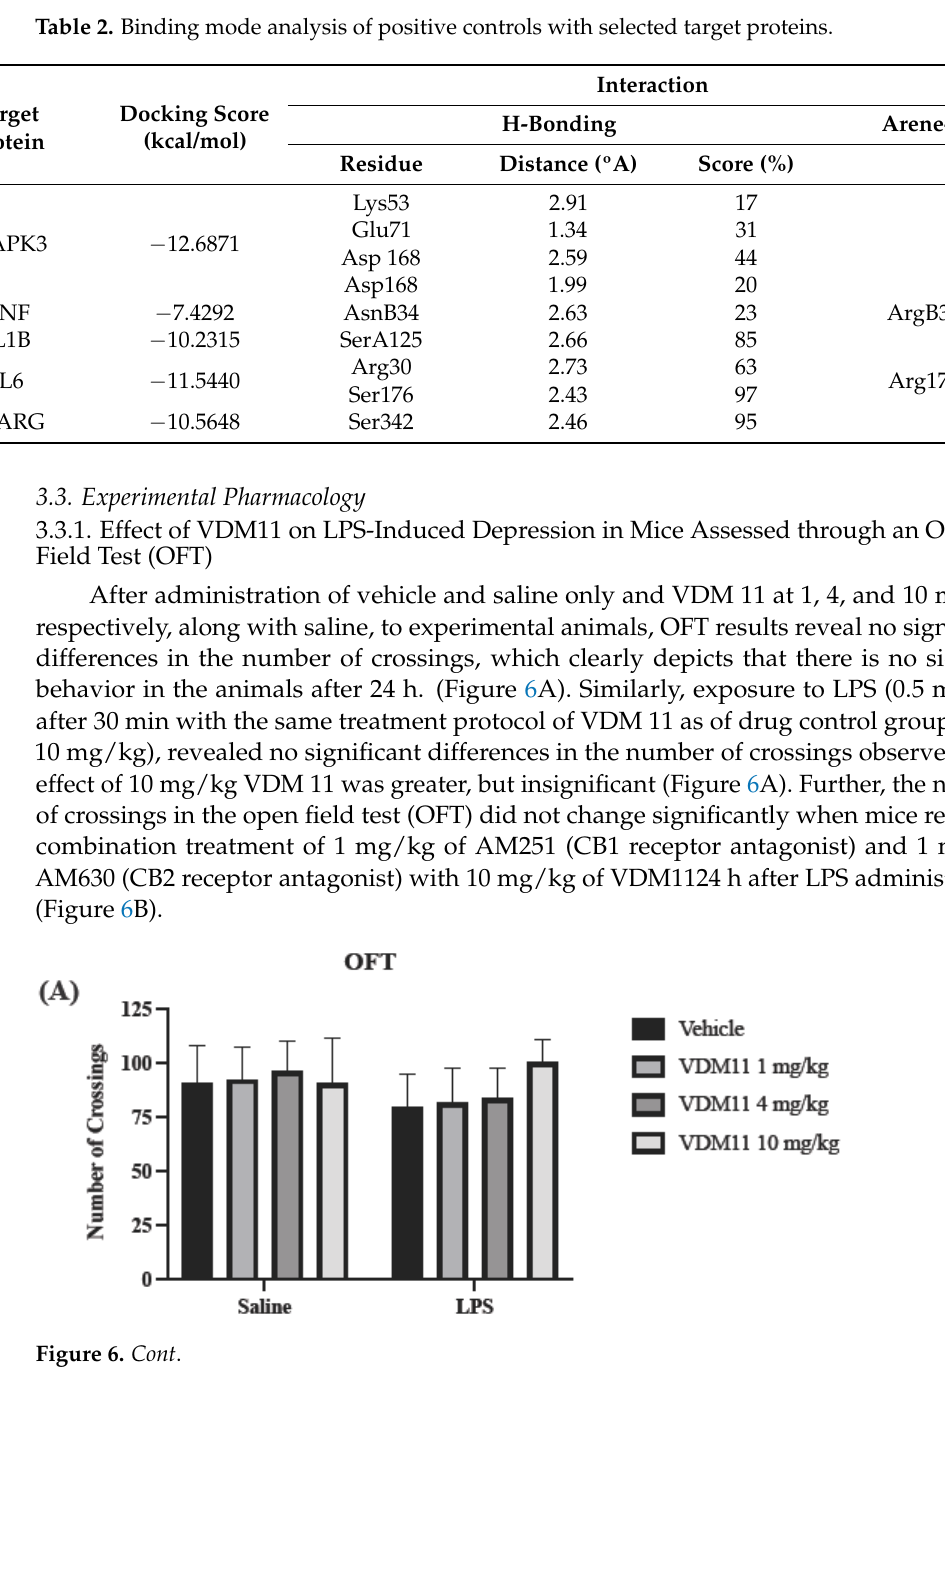
Figure 6. ( A ) Mice given various doses of VDM11, an anandamide reuptake inhibitor, 24 h after LPS injection did not significantly modify the number of crossings in the open field test (OFT). ( B ) Mice treated with a combination of 1 mg/kg each of the CB1 receptor antagonist AM251 and the CB2 receptor antagonist AM630, along with 10 mg/kg each of the anandamide reuptake inhibitor VDM11 24 h after LPS administration, did not experience a significant change in the number of crossings in the open field test (OFT) . 3.3.2. Effect of VDM11on LPS-Induced Depression in Mice Assessed through Elevated Plus Maze Test The elevated plus maze test was performed after 25 h of LPS administration to ex- perimental animals. The results of the test revealed that there were no significant differ- ences in open arm exploration times in animals when treated with VDM 11 only at differ- ent doses. Meanwhile, administration of LPS to experimental animals significantly re- duced the open arm exploration times % in animals. The open arm exploration time’s percentage was found to be increased in animals which were pretreated with VDM11 at different dose levels. The most significant results were observed at 10 mg/kg of VDM11 pretreatment (Figure 7A). Combination treatment of CB1 and CB2 receptor antagonists (AM 251 and AM 630, respectively, 1 mg/ kg each) decreased open arm exploration times (%) in animals exposed to LPS, even in those pretreated with VDM11 at 10 mg/kg (Figure 7B).